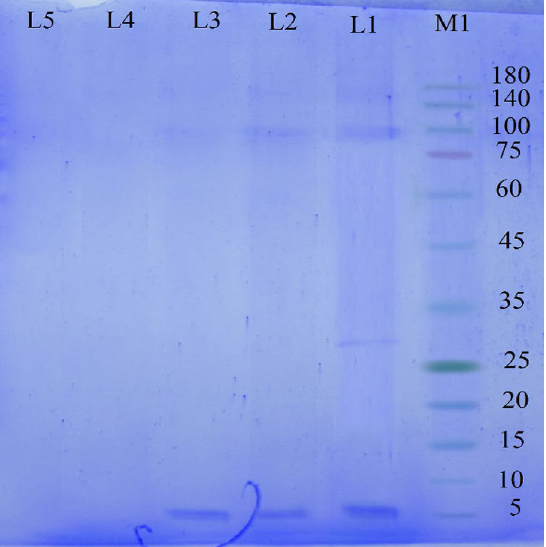
Figure 6. SDS-PAGE of purified recombinant buforin I using Ni–NTA column: M) protein marker, L1) Elution 1, L2) Elution 2, L3) Elution 3, L4) Elution 4 and L5) negative control ( E. coli BL21 without recombinant plasmid).